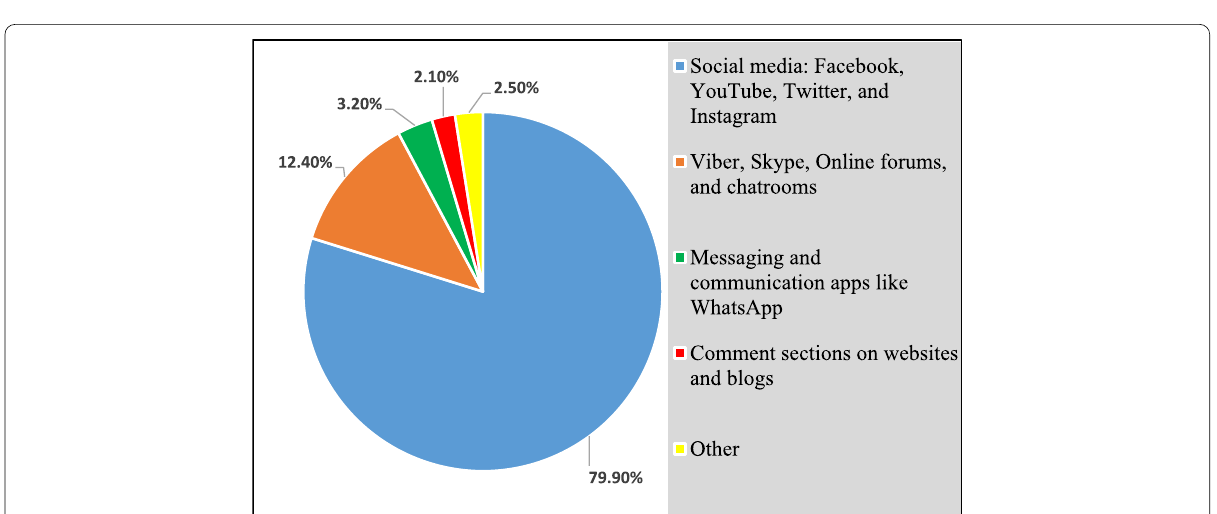
Fig. 2 Worst platforms regarding online TFSV as reported by the harassed study participants ( n